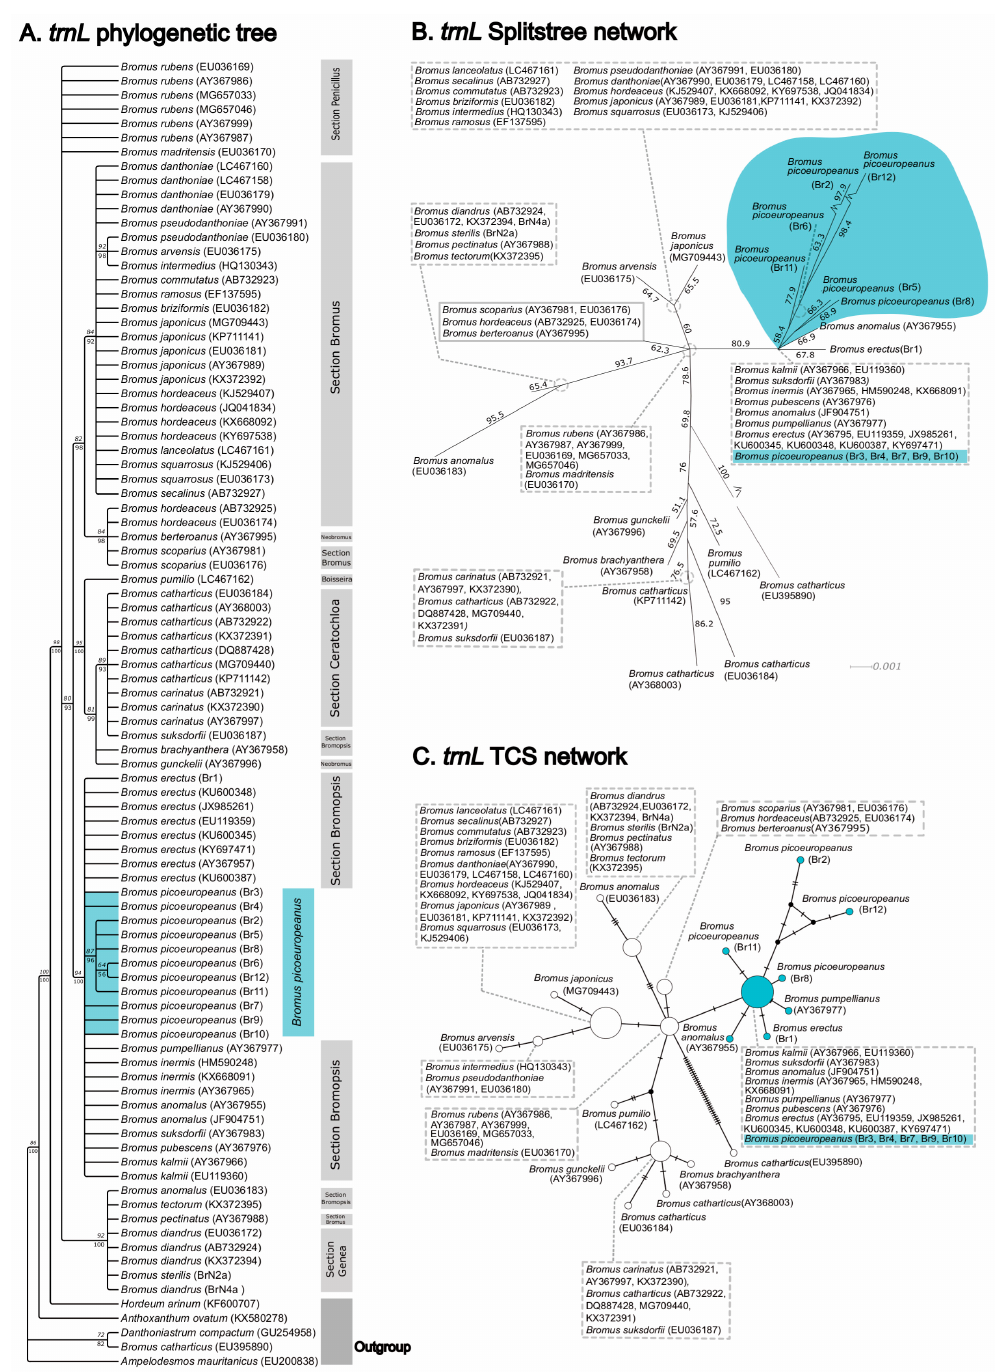
Figure 5. Phylogenetic and network analyses based on trnL sequences. ( A ) Consensus phylogenetic tree was obtained from the ML and BI analyses based on the plastid marker trnL. The numbers over the branches correspond to the bootstrap (BS) values from the ML analysis. The posterior probabilities (PP) were obtained during the BI analysis, whereas the numbers under the branches represent the posterior probabilities (PP) obtained during the BI analysis. Br: new Bromus samples were employed in this study. The Br samples from the Cantabrian Mountains and from Picos de Europa have been highlighted in blue. The Br samples from lower lands has been highlighted in gray. ( B ) Phylogenetic network generated by SplitsTree based on the trnLB dataset. Numbers near the branches represent bootstrap support values (BS). ( C ) TCS network obtained based on the trnLB dataset. Br: Bromus samples were generated in this study.